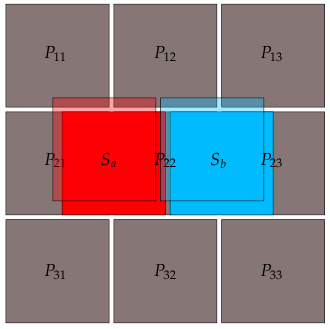
Figure 10. Matrix